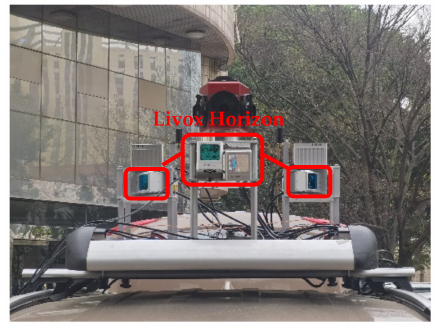
Figure 8. Passenger car platform